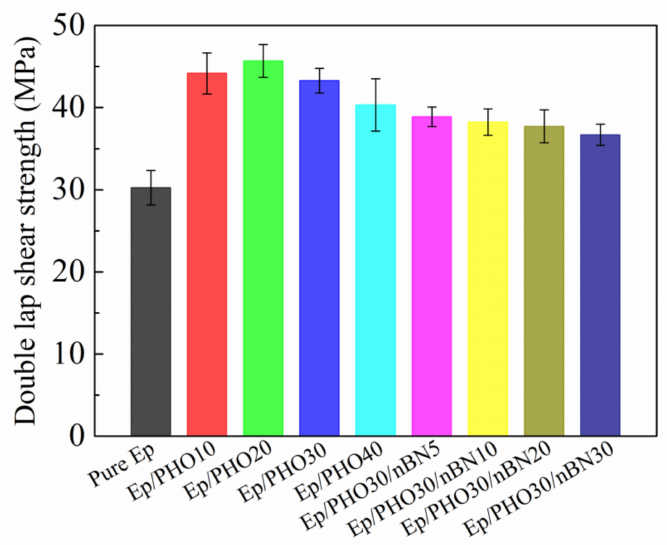
Figure 6. Double-lap shear strength of different adhesive systems.